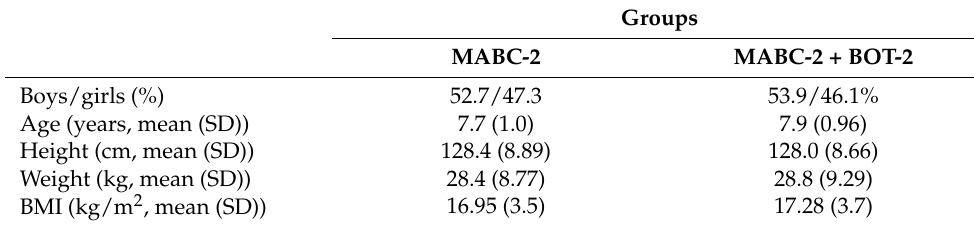
Table 1. Demographic information of Participants Part 1 (MABC-2; n = 444) and Participants Part 2 (MABC-2 and BOT-2; n = 165).